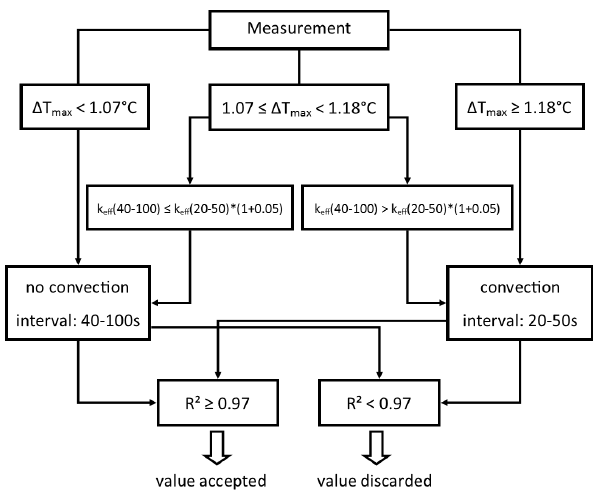
Figure 3. Schematic of the algorithm used to determine automati- cally the thermal conductivity value from the heating curves. (cid:49)T max is the temperature rise measured after 100s of heating.